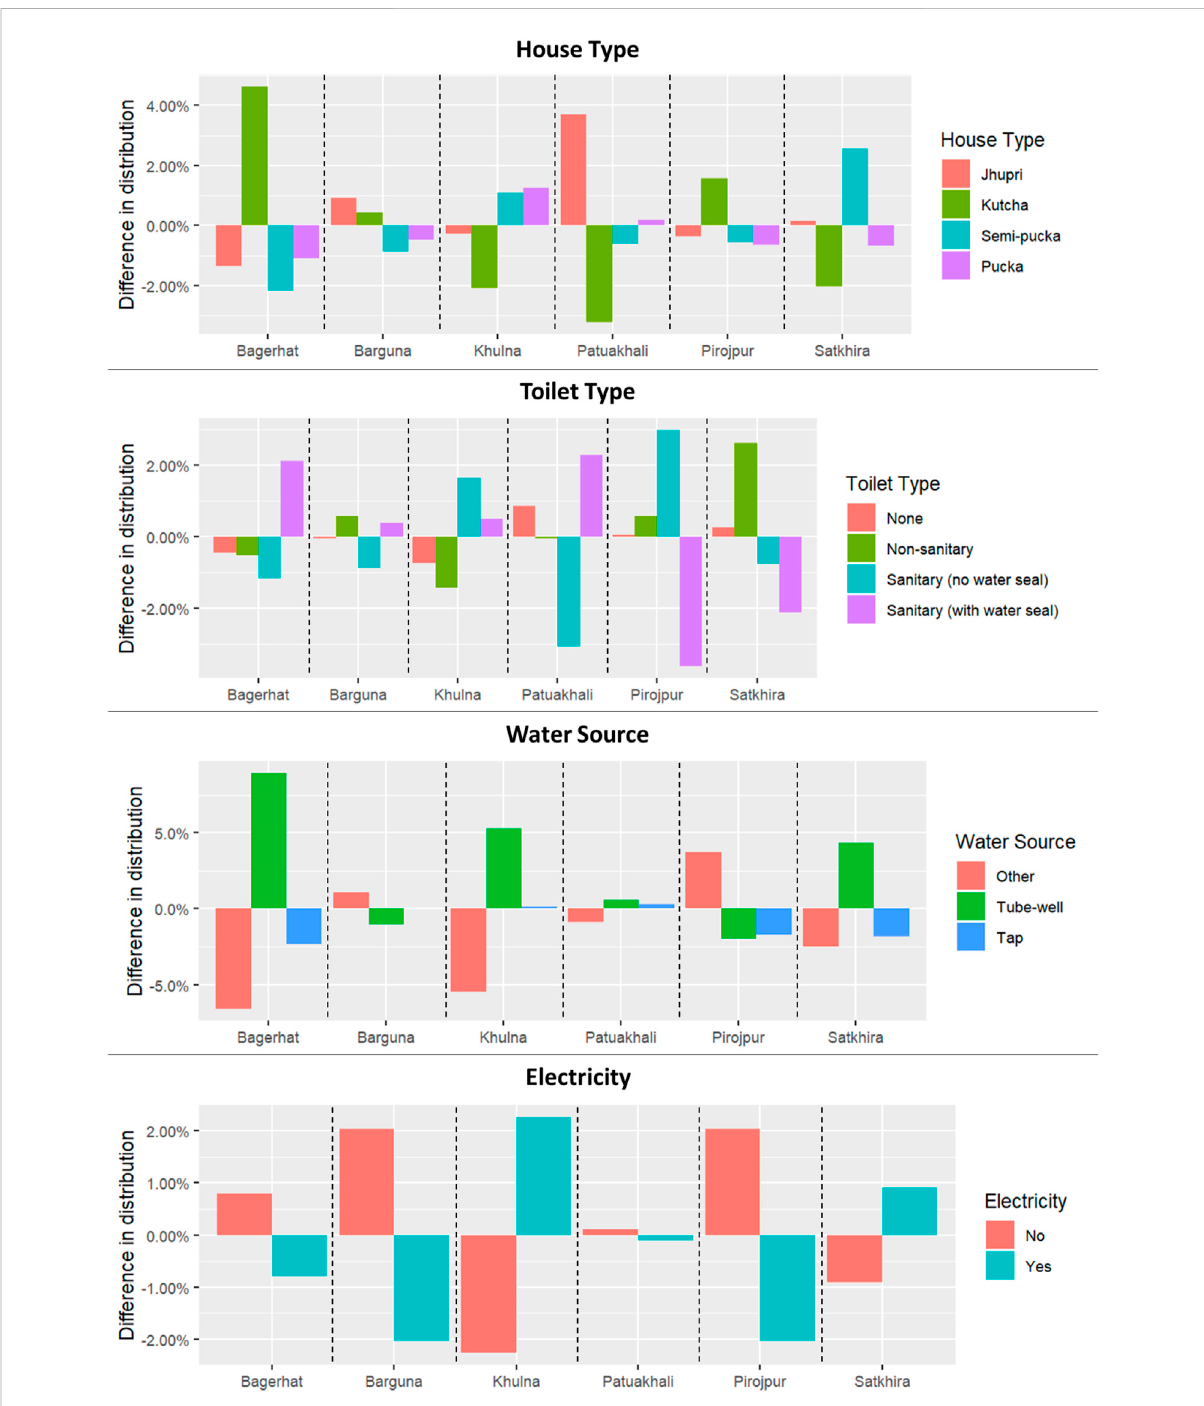
FIGURE 5 Difference from the expected distribution for variables of modelled potentially fl ooded